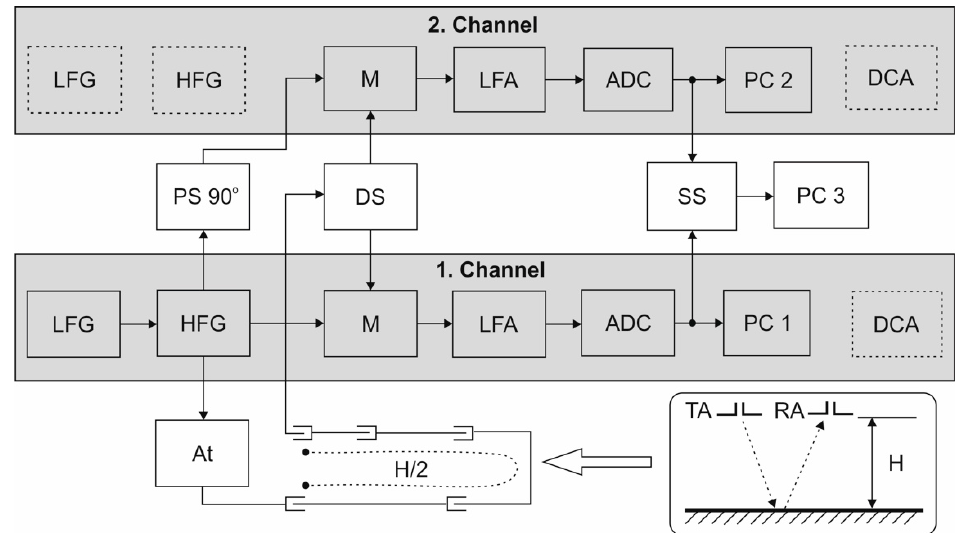
Figure 5. Laboratory double-channel radio altimeter block diagram created from two one-channel radio altimeters: LFG is the low-frequency generator, HFG is the high-frequency generator, PS 90° is the 90-degree phase shifter, At is the attenuator, M is the mixer, DS is the signal divider, LFA is the low-frequency amplifier, ADC is the analog-to-digital converter, SS is the signal summator, PC is the pulse counter, DCA is the direct current amplifier, TA is the transmitting antenna, RA is the receiving antenna , H is the altitude, are the original blocks of a one-channel radio altimeter not used in the laboratory double-channel radio altimeter.